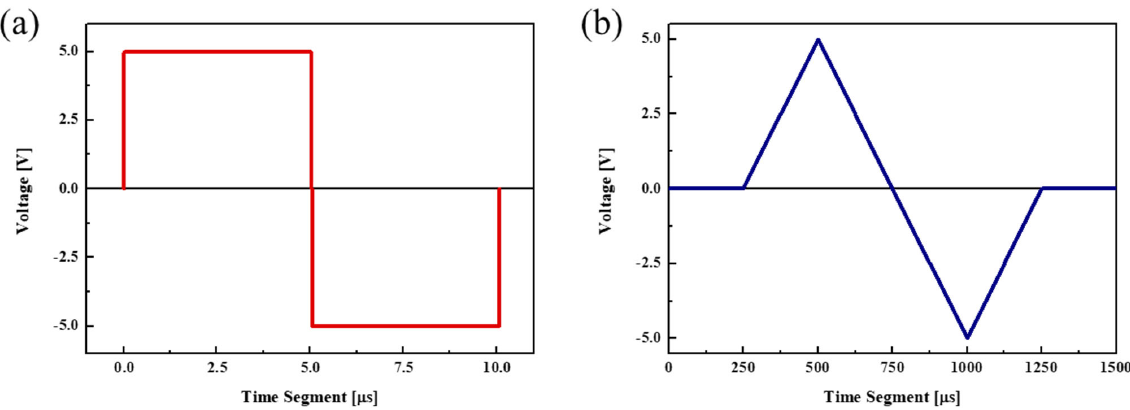
Figure 10. Pulse shapes used in the characteristics analysis: ( a ) rectangular and ( b ) triangular pulses.